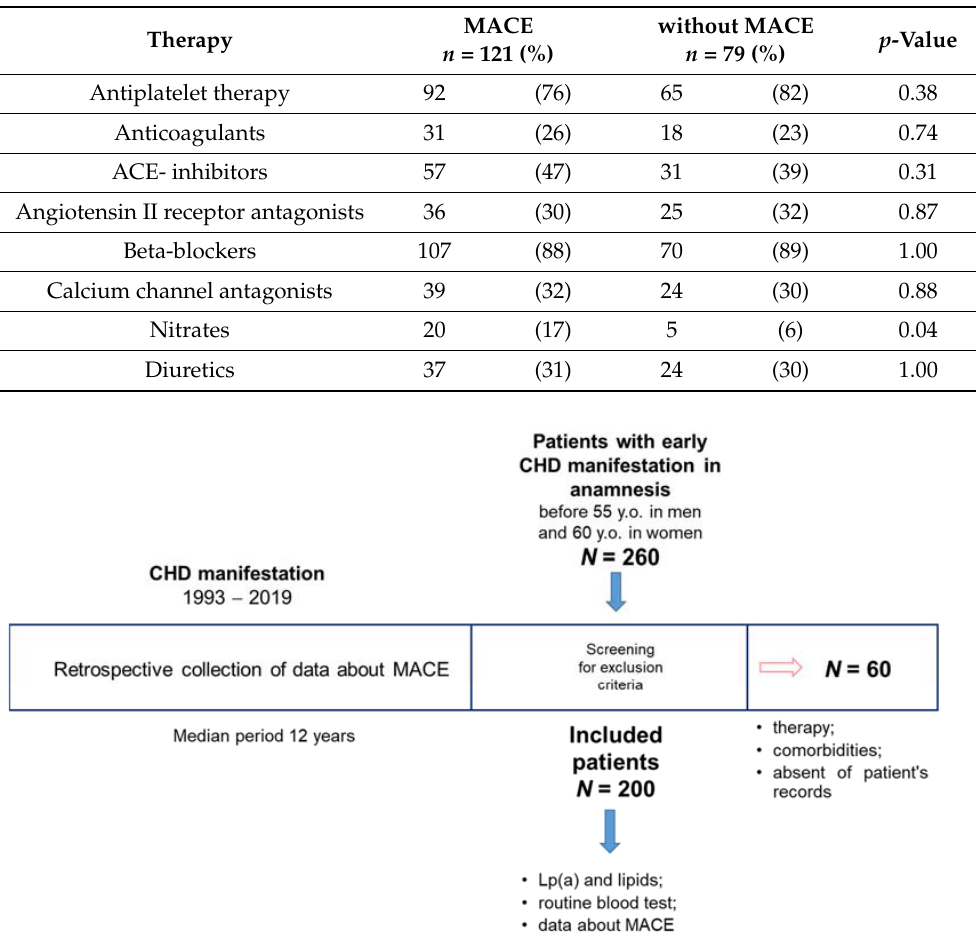
Table A1. Therapy performed in the examined patients.